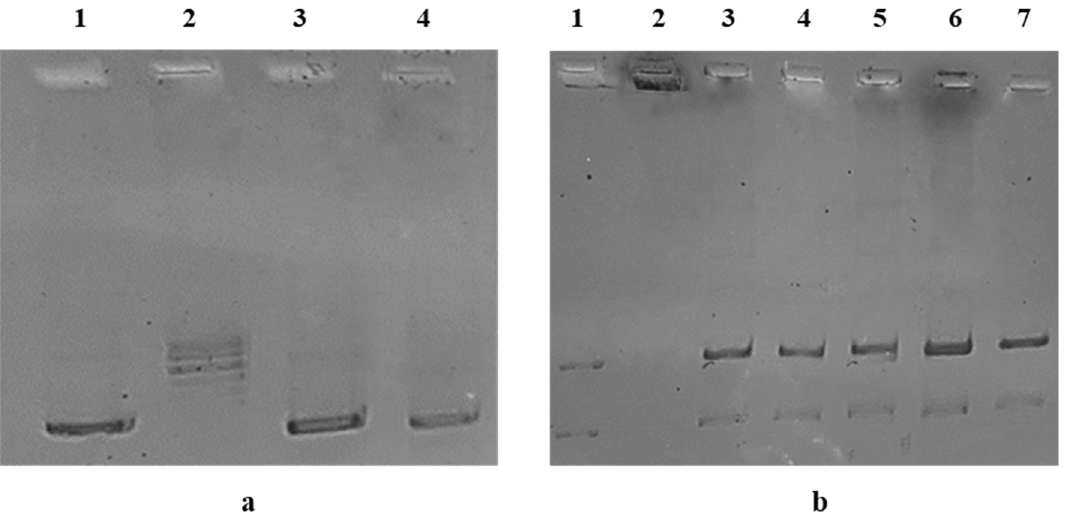
Figure 3. ( a ) hTopo I supercoiled relaxing activity. hTopo I was exposed to the vehicle alone (DMSO,